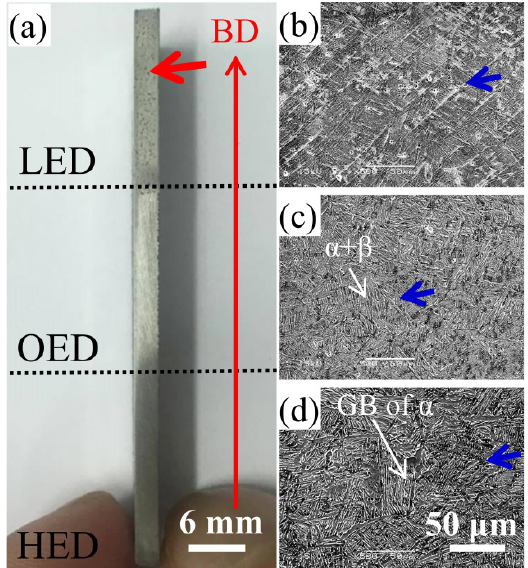
Figure 3. Side view of specimen from bottom to top along the build direction (BD) denoted in red arrow of ( a ) showing the high visible pores which range from several hundred μm to several mm in size denoted by red arrow in LED built zone. SEM secondary electron images shows smaller pores several μm in size denoted by blue arrows in ( b ) LED, ( c ) OED and ( d ) HED built zones. Besides, α+β lamella and grain bound (GB) of α structure denoted by white arrows both were observed in ( c ) OED and (d) HED built zones.